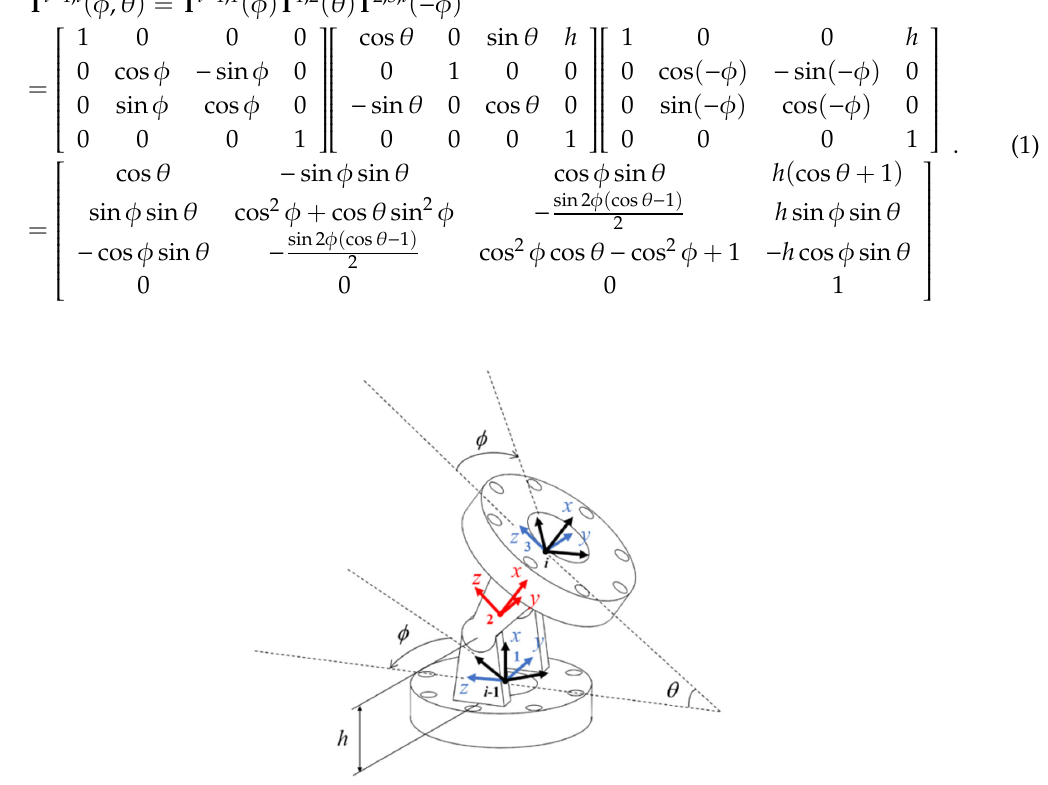
Figure 4. Diagram of a single-joint section.